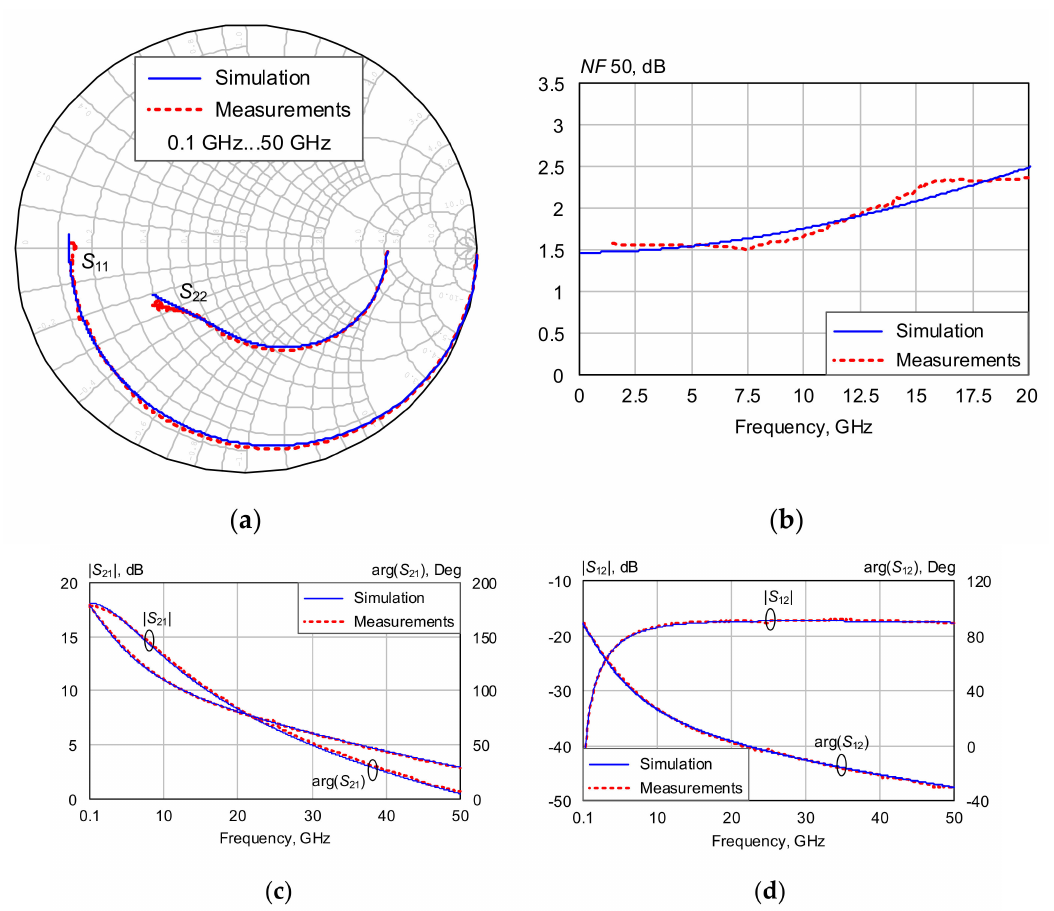
Figure 6. A comparison between measured and simulated S-parameters, and 50-ohm noise figure for a 4 × 50 µ m pHEMT at the bias point Vds = 3 V, Ids = 20 mA: ( a ) S11—input reflection coefficient, S22—output reflection coefficient; ( b ) 50-ohm noise figure; ( c ) S21—small-signal gain; ( d ) S12—reverse transmission